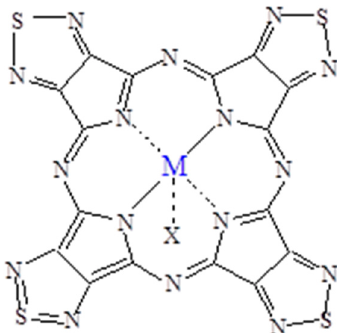
Figure 2. X-ray powder spectra of [Py 8 TPyzPzIn(OAc)]·8H 2 O ( A ), [Py 8 TPyzPzAlCl]·8H 2 O ( B ) and